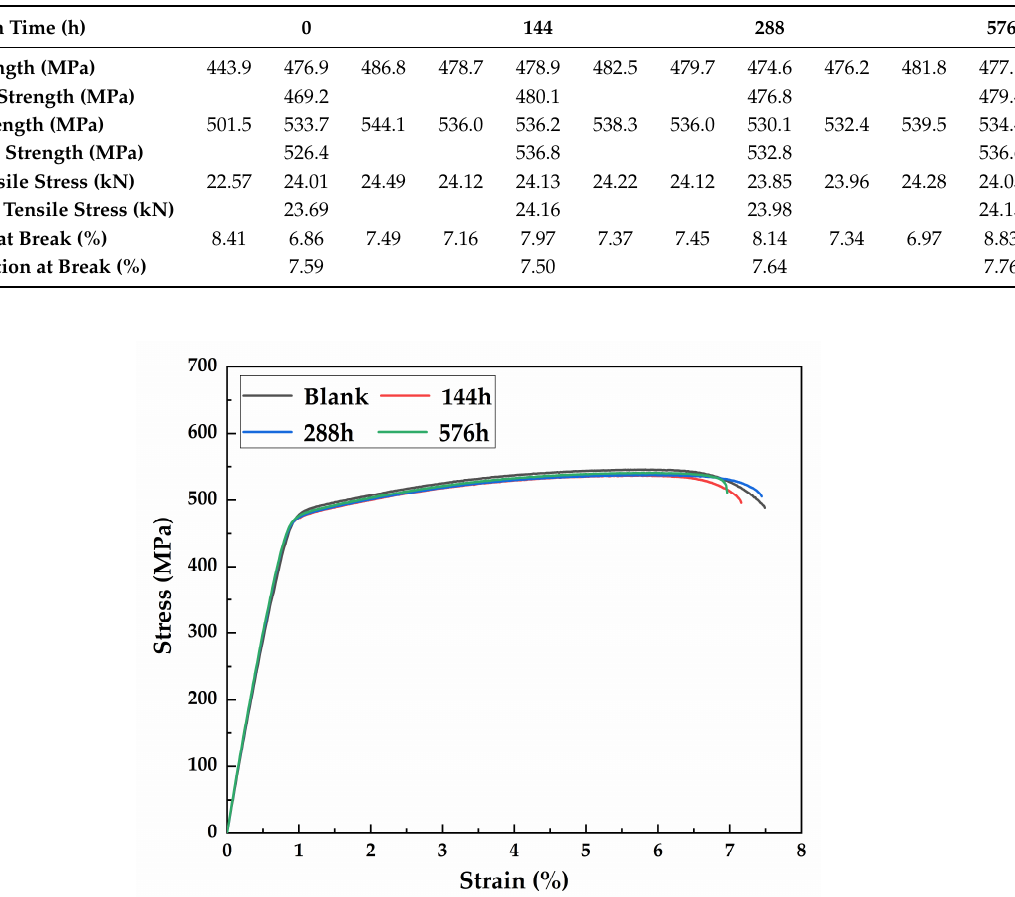
Table 3. Tensile properties of the 7B04-T74 aluminum alloy after alternate immersion test.